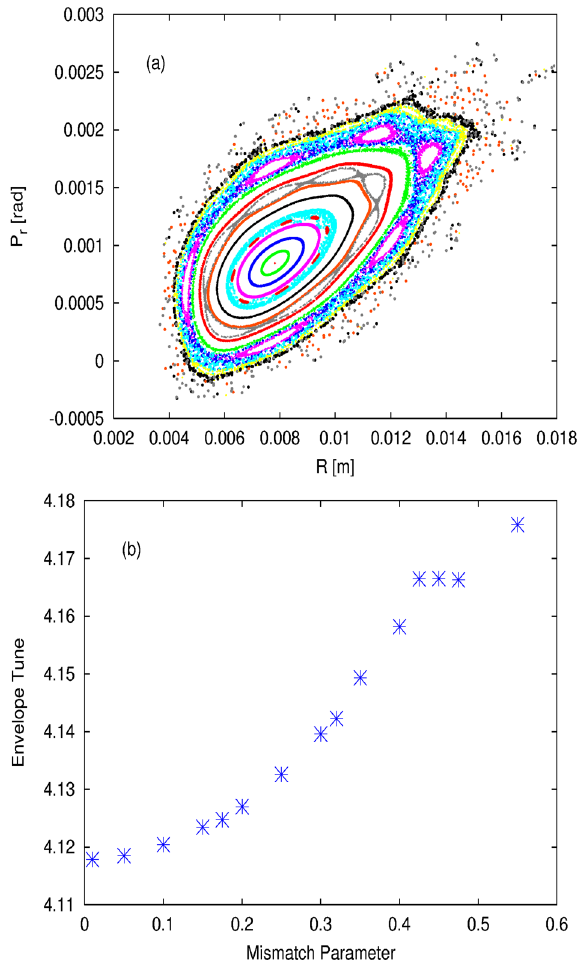
FIG. 8. (Color) (a) Stroboscopic map of the envelope in the PSR lattice for a beam with intensity equal to one-half of the full PSR beam intensity listed in Table I. The colors represent varying levels of mismatch. (b) Envelope tune versus the